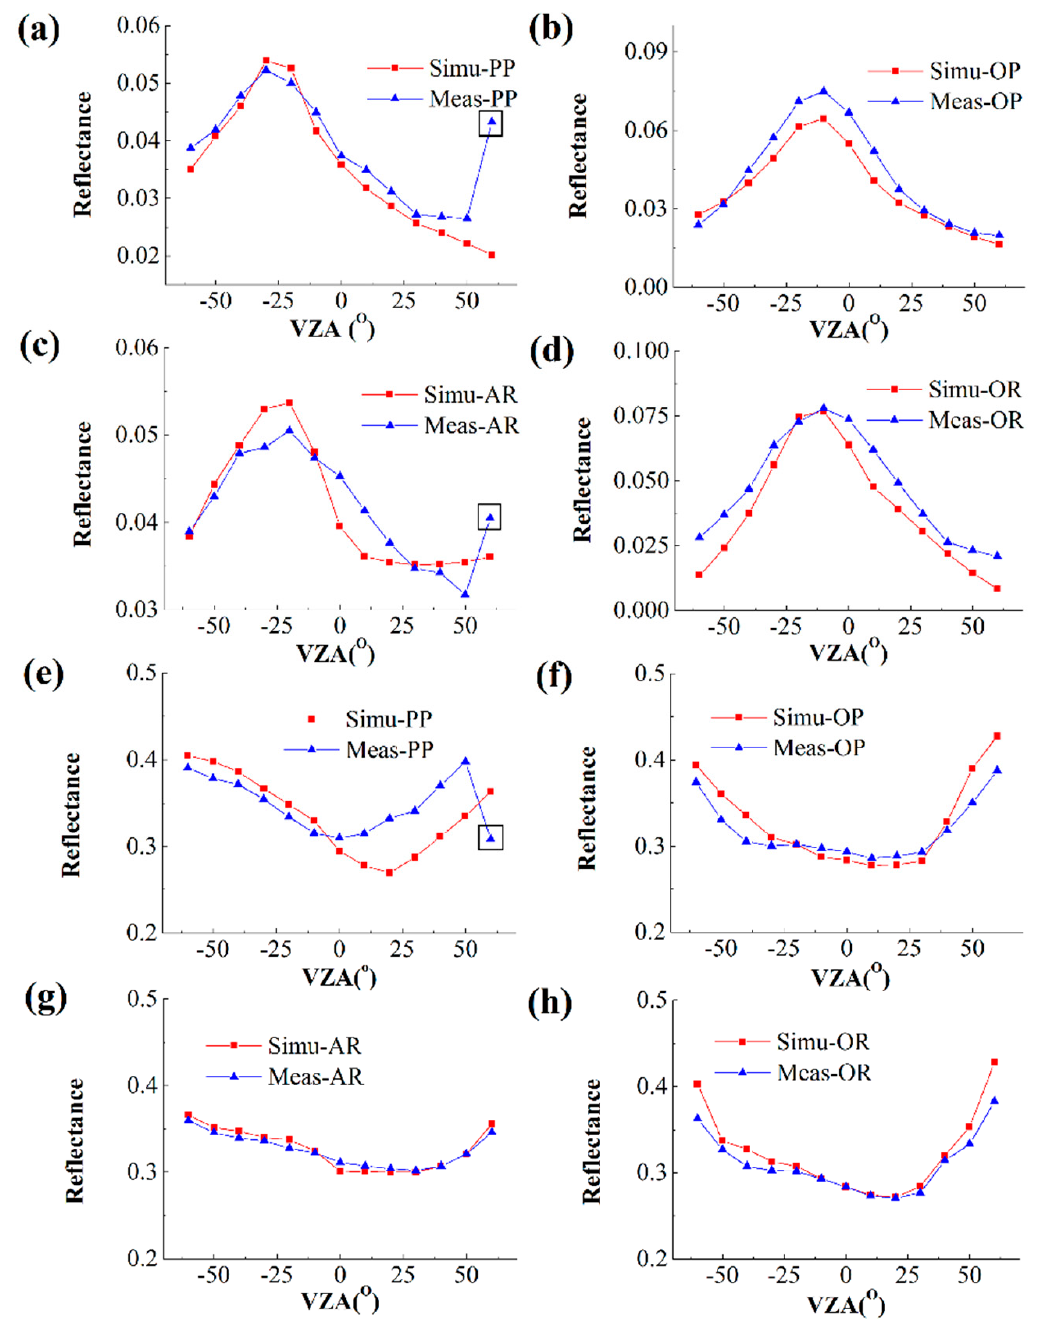
Figure 11. Comparison of the distribution of the sum of the reflectance simulated by the row model and field data in the multiangle observation for the principal plane (PP) mode ( a , e ), orthogonal plane (OP) mode ( b , f ), along-row plane (AR) mode ( c , g ), and orthogonal row plane (OR) mode ( d , h ). ( a – d ) Red band (670 nm); ( e – h ) NIR band (860 nm). VZA is the viewing zenith angle. The black box is the abnormal point in the measurement.